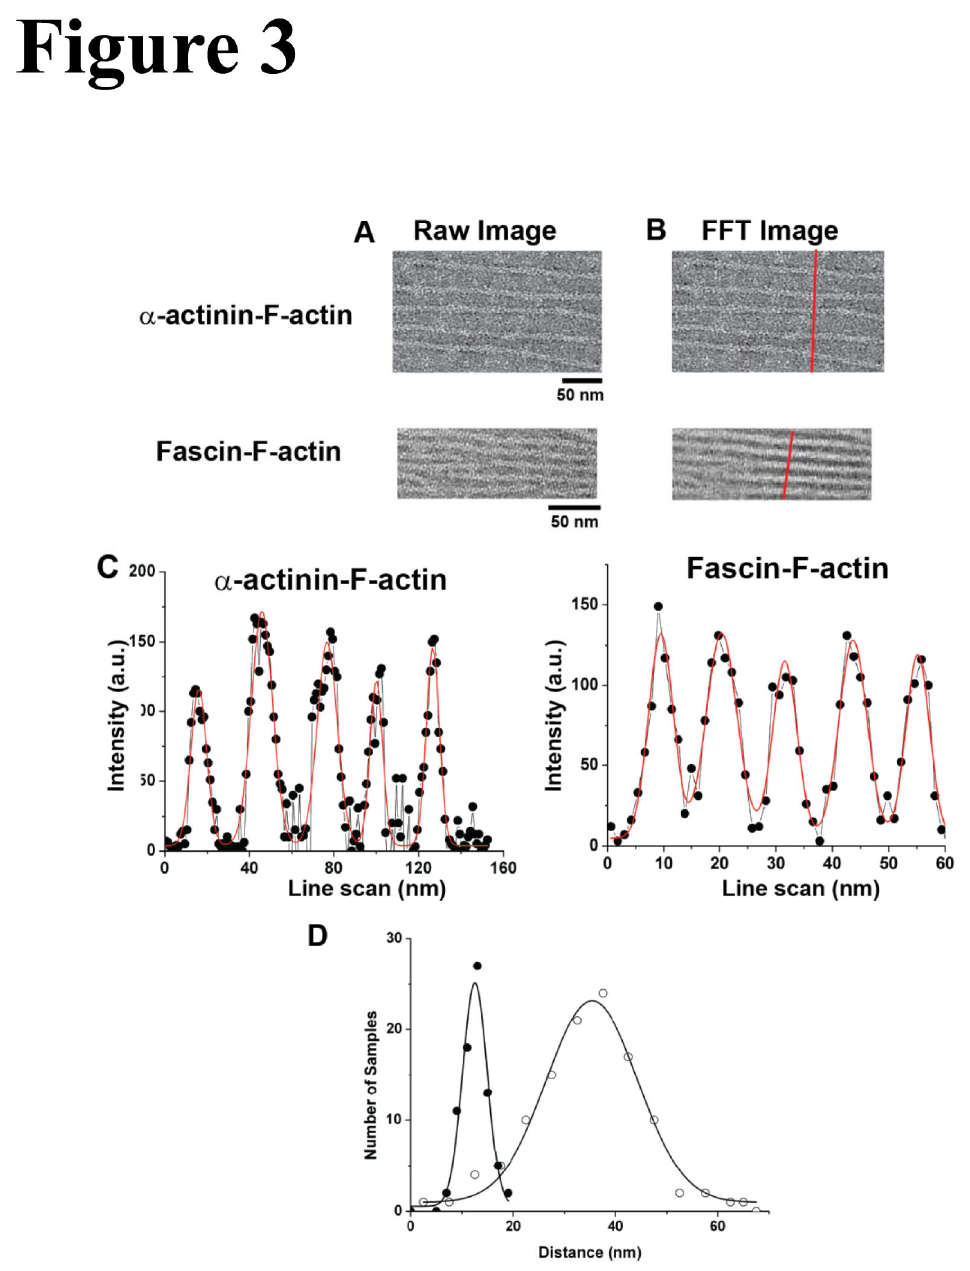
Figure 3. Analysis of the electron micrograph of fascin- and α-actinin-F-actin rafts. (A) Unprocessed electron microscope images of actin rafts created with α-actinin (top) or fascin (bottom). (B) Same images transformed with a fast Fourier transform (FFT) filter, a line scan (red line) analysis of the intensities. (C) Intensity profile from the line scan in (B). The data were fit with sum of Gaussians (red lines). The peaks represent the position of actin filaments in the rafts. (D) Histogram of the center-to-center distance between actin filaments with fascin (closed circle) and α-actinin (open circle) analyzed with single Gaussian distribution (solid line). The average distances of fascin- and α-actinin-F-actin rafts were 12.5 ± 2.3 nm (n = 78, mean ± S.D.) and 39.7 ± 16.5 (n = 97, mean ± S.D.), respectively.